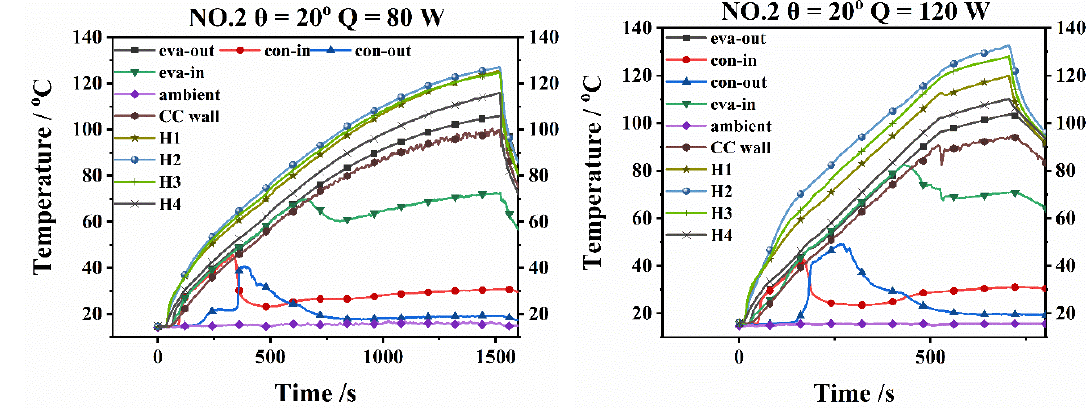
Figure 9. Temperature response during start up process of No.2 position at 80 W and 120 W.